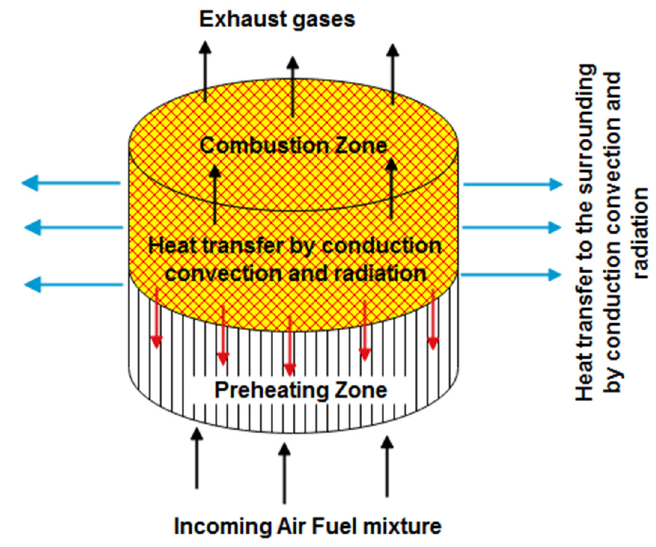
Figure 3. Heat transfer mechanism in a double layer PM.